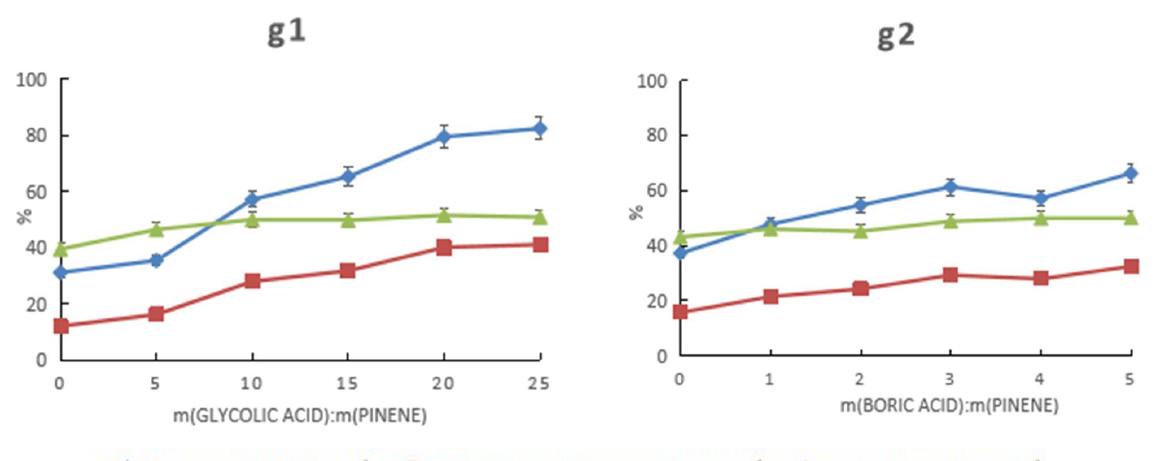
Figure 1. Effect of the HCA–boronic acid mixture composition on the conversion of α-pinene and the GC-determined content and selectivity of terpineol. ( a – g ) refer to citric acid, L -(+)-tartaric acid, DL -mandelic acid, L -(−)-malic acid, D -gluconic acid, D -(−)-lactic acid, and glycolic acid, respectively. The graphs on the left (a1–g1) show the effects of HCAs on catalytic performance under the following reaction conditions: m(α-pinene)/m(water)/m(acetic acid)/m(boric acid) = 10:10:25:0.4, reaction temperature of 60 °C, and a reaction time of 24 h. The graphs on the right (a2–g2) show the effects of boric acid on catalytic performance under the following reaction conditions: m(α-pinene)/m(water)/m(acetic acid)/m(HCAs) = 10:10:25:1, reaction temperature of 60 °C, and a reaction time of 24 h.